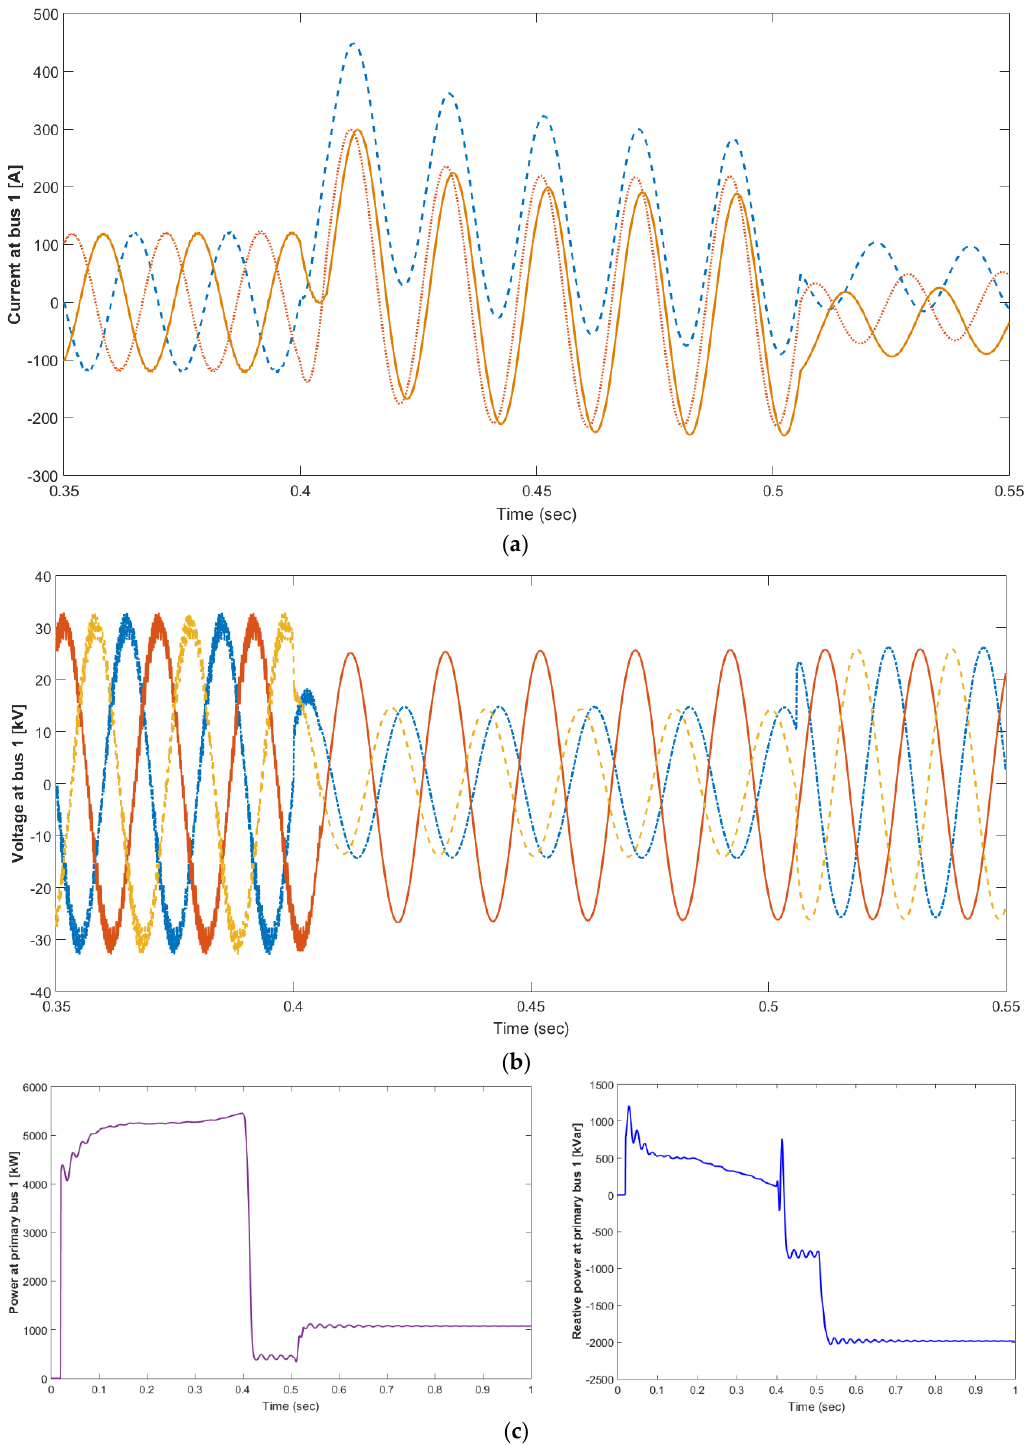
Figure 11. ( a ) Currents in the MV park bus 1 during a three-phase-to-ground fault at the 22 kV-side. ( b ) Voltage at the MV park bus 1 during a three-phase-to-ground fault at the 22 kV-side. ( c ) Active and reactive powers at the MV park bus 1 during a three-phase-to-ground fault at the 22 kV-side. Figure 12a shows voltages in the LV bus side in the case of a one-phase-to-ground